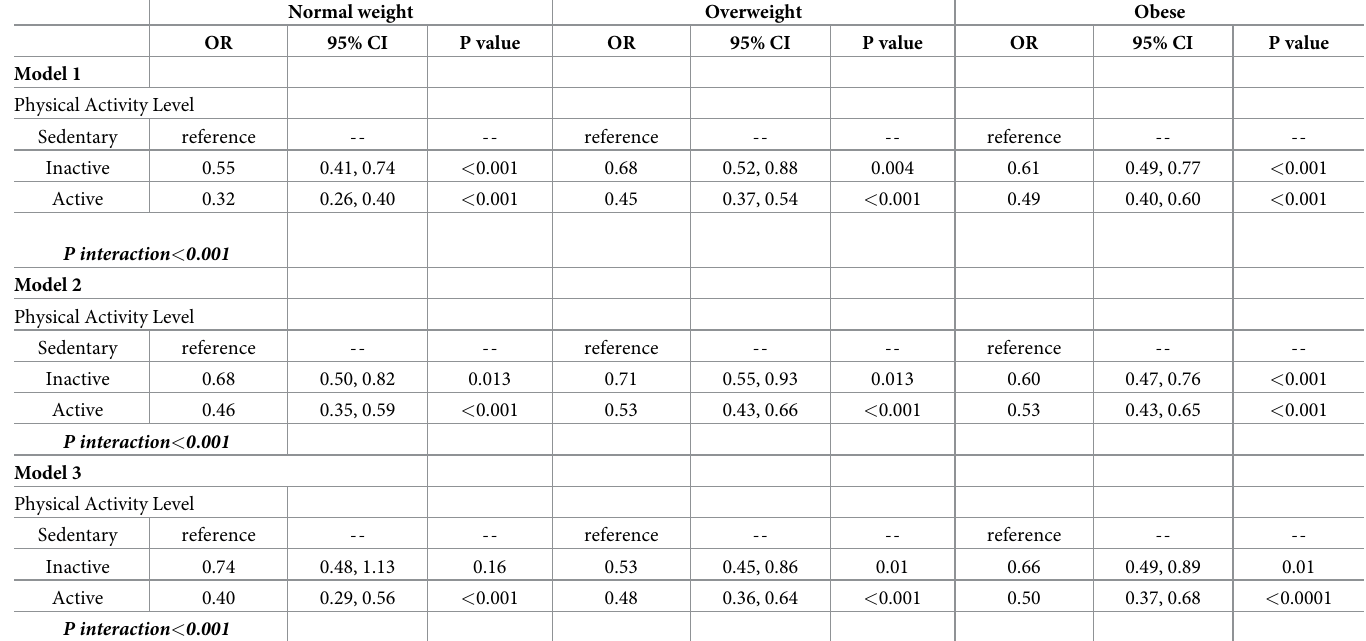
Table 3. The association of physical activity level and high 10-year CVD risk by weight status among U.S adults age 30–65 years old with no history of cardiovascu- lar disease (population-weighted, NHANES 2007–2016). Normal weight Overweight